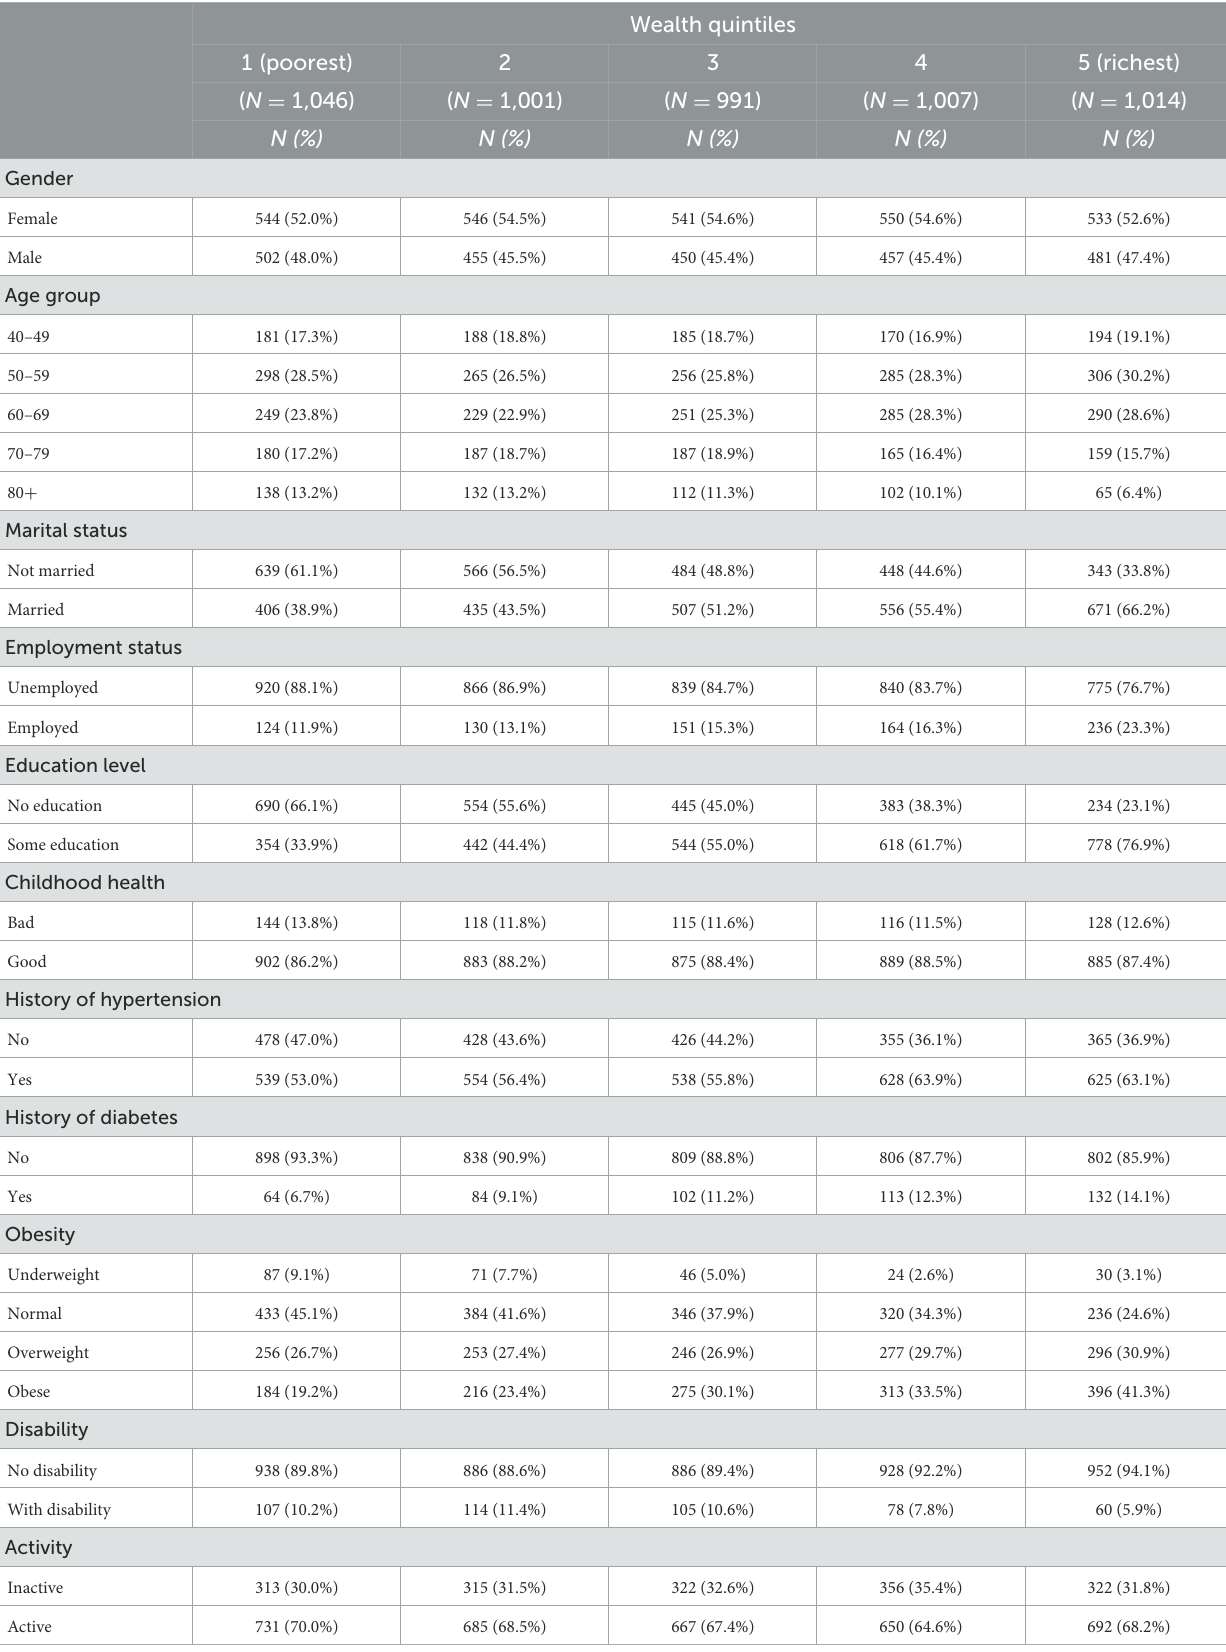
TABLE 1 Characteristics of participants based on their wealth